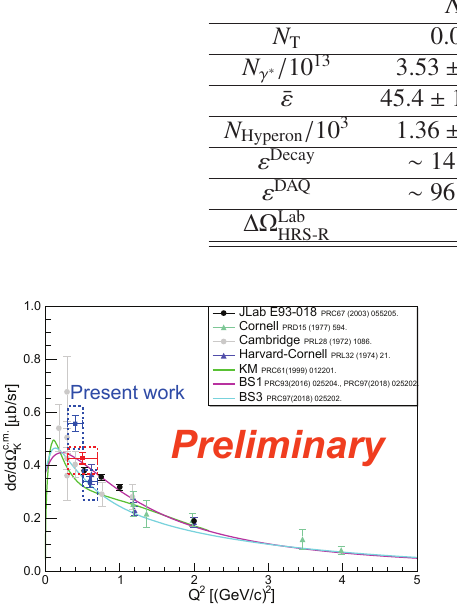
Figure 2. The Q 2 dependency of the di ff eren- tial cross sections for the Λ hyperon electro- production (see text).